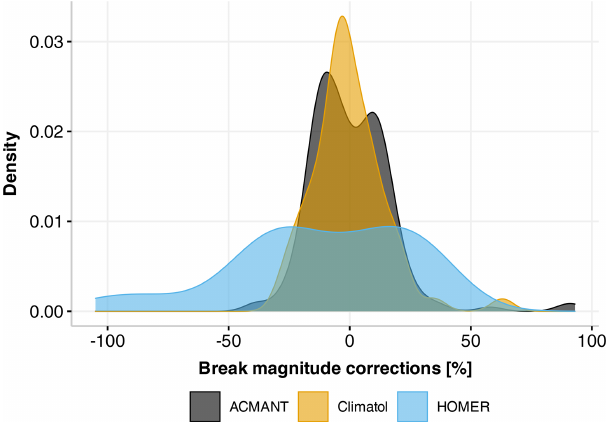
Figure 4. Density plots for break magnitude corrections for AC- MANT, Climatol, and HOMER.